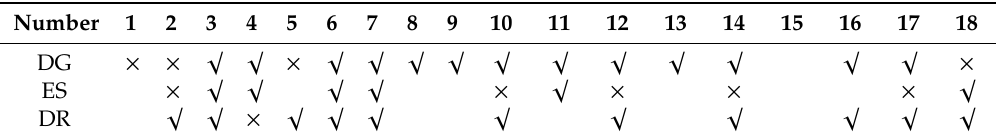
Table 4. Final aggregation